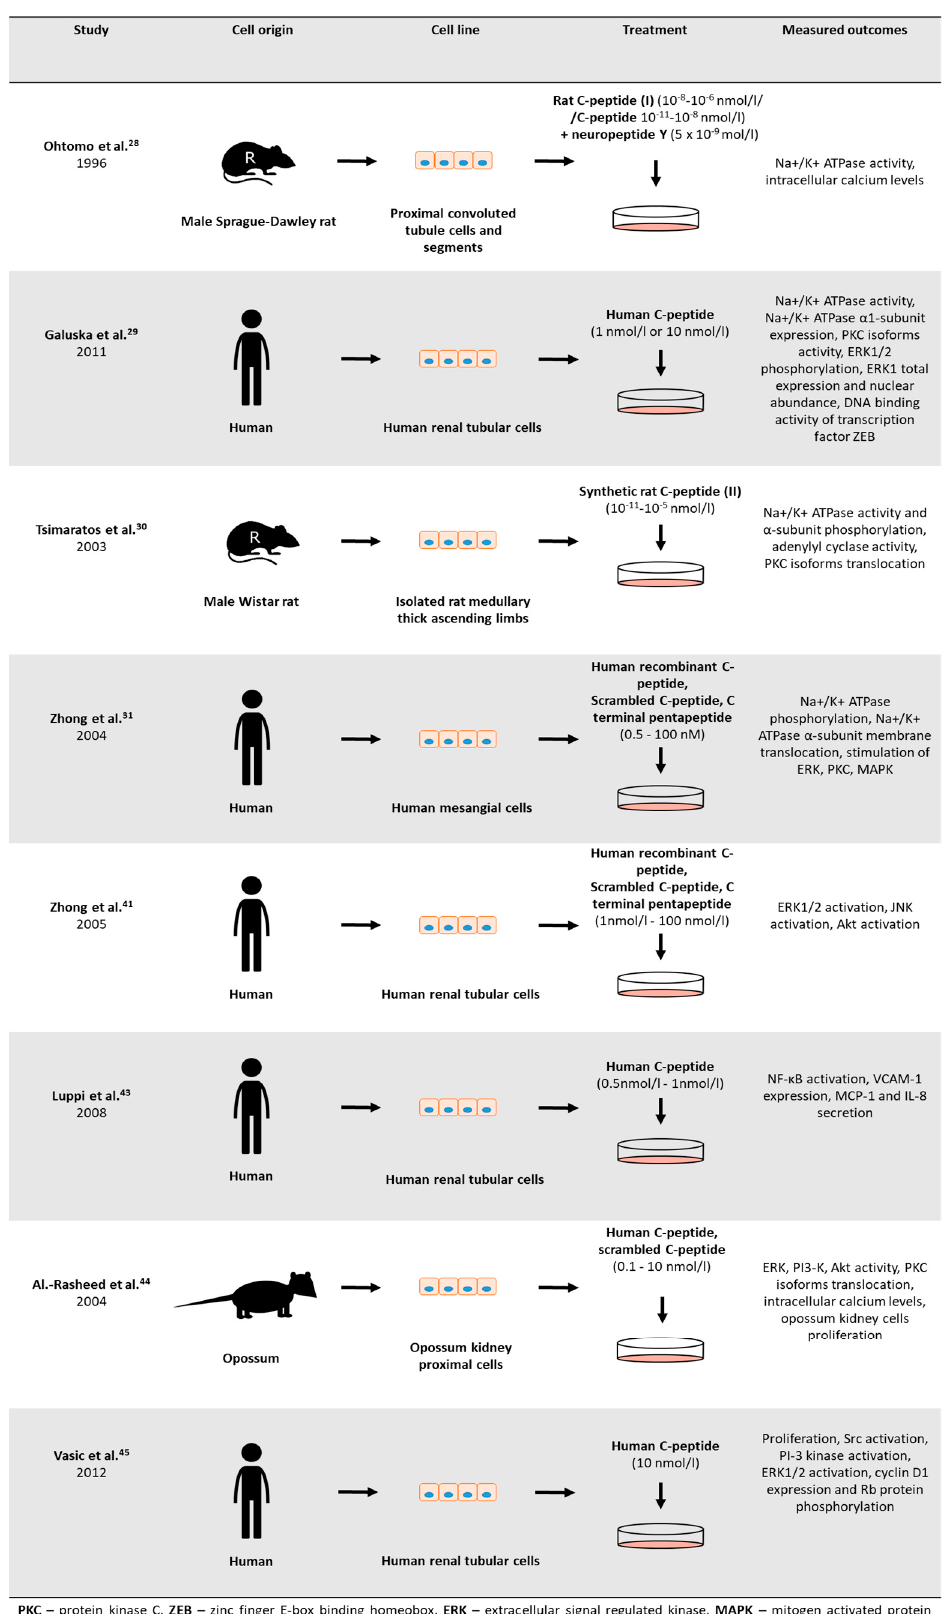
Figure 3. Study design of in vitro studies reviewed in this paper.